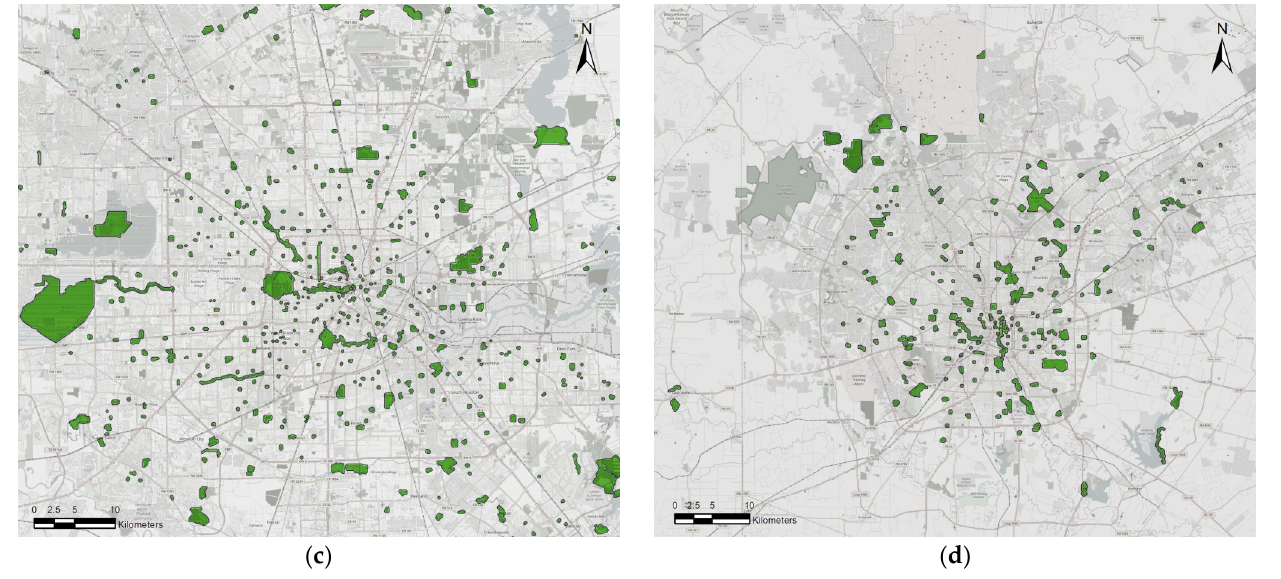
Figure 3. Distribution of green spaces in four major cities: ( a ) Austin, ( b ) Dallas, ( c ) Houston, and ( d ) San Antonio.